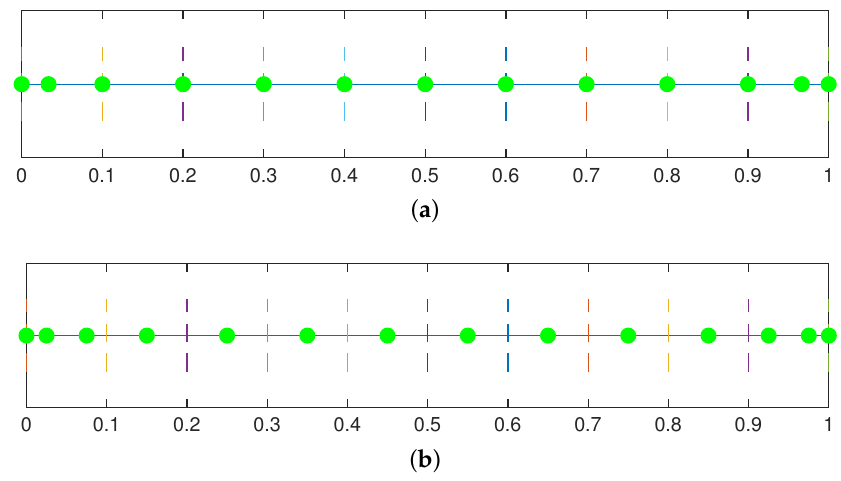
Figure 4. Greville points. ( a ) Odd degree ( p = 3). ( b ) Even degree ( p =